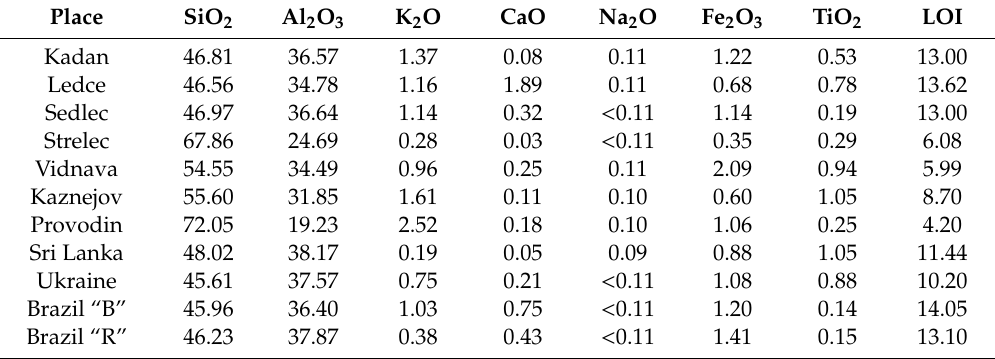
Table 2. The Chemical Analysis of the Samples of Kaolin and Kaolinitic Clay Used (in wt. %).